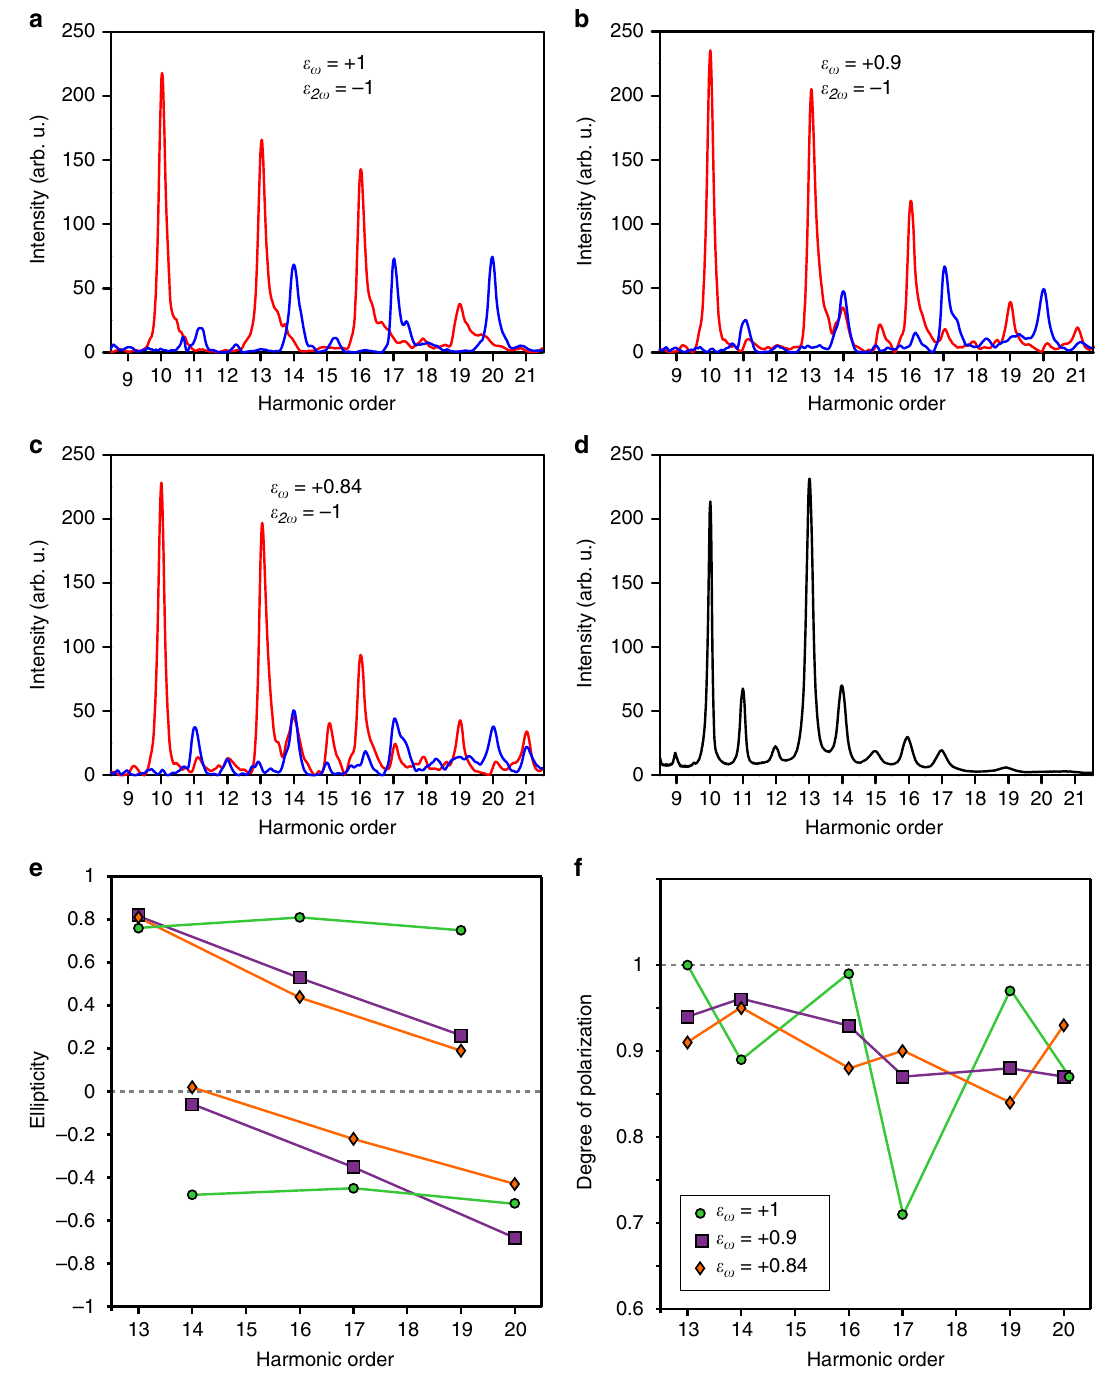
Fig. 3 Effects of a slight ellipticity of the ω driving fi eld in argon. a – c High harmonic spectra calculated in argon for trapezoidal pulses of maximal intensity 1.2 × 10 14 W/cm² and ω driver ellipticities ε ω = + 1 ( a ) + 0.9 ( b ) and + 0.84 ( c ), the 2 ω driver being kept perfectly circular ( ε 2 ω = − 1). The components co- rotating and counter-rotating with the ω fi eld are shown in red and blue, respectively. d Experimental harmonic spectrum generated in argon in the conditions described in Fig. 4 and measured with the XUV spectrometer. e – f Ellipticity ( e ) and degree of polarization ( f ) calculated over the harmonic spectral width ( + / − 0.25 order around the peak), for the 3 q + 1 and 3 q + 2 orders simulated in the plateau region above the ionization potential of